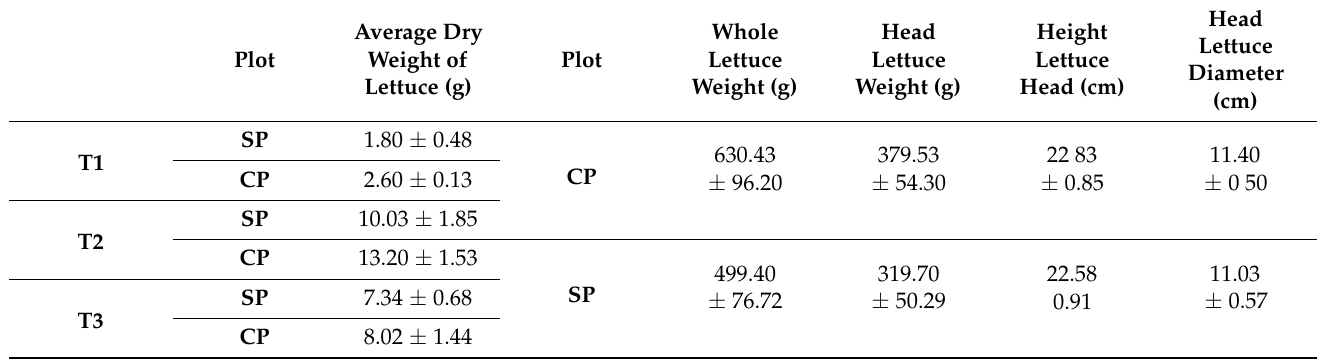
Table 1. Average dry weight and characteristics of the whole lettuce in T1 and T2, and of the lettuce head and the water content in T3 for the control plot (CP) and the saline plot